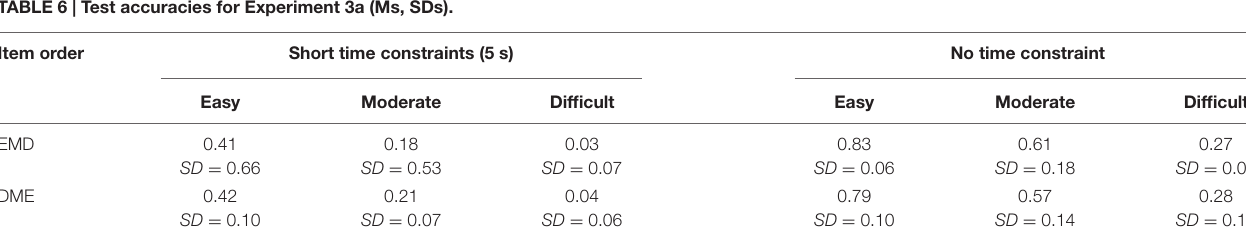
TABLE 6 | Test accuracies for Experiment 3a (Ms,